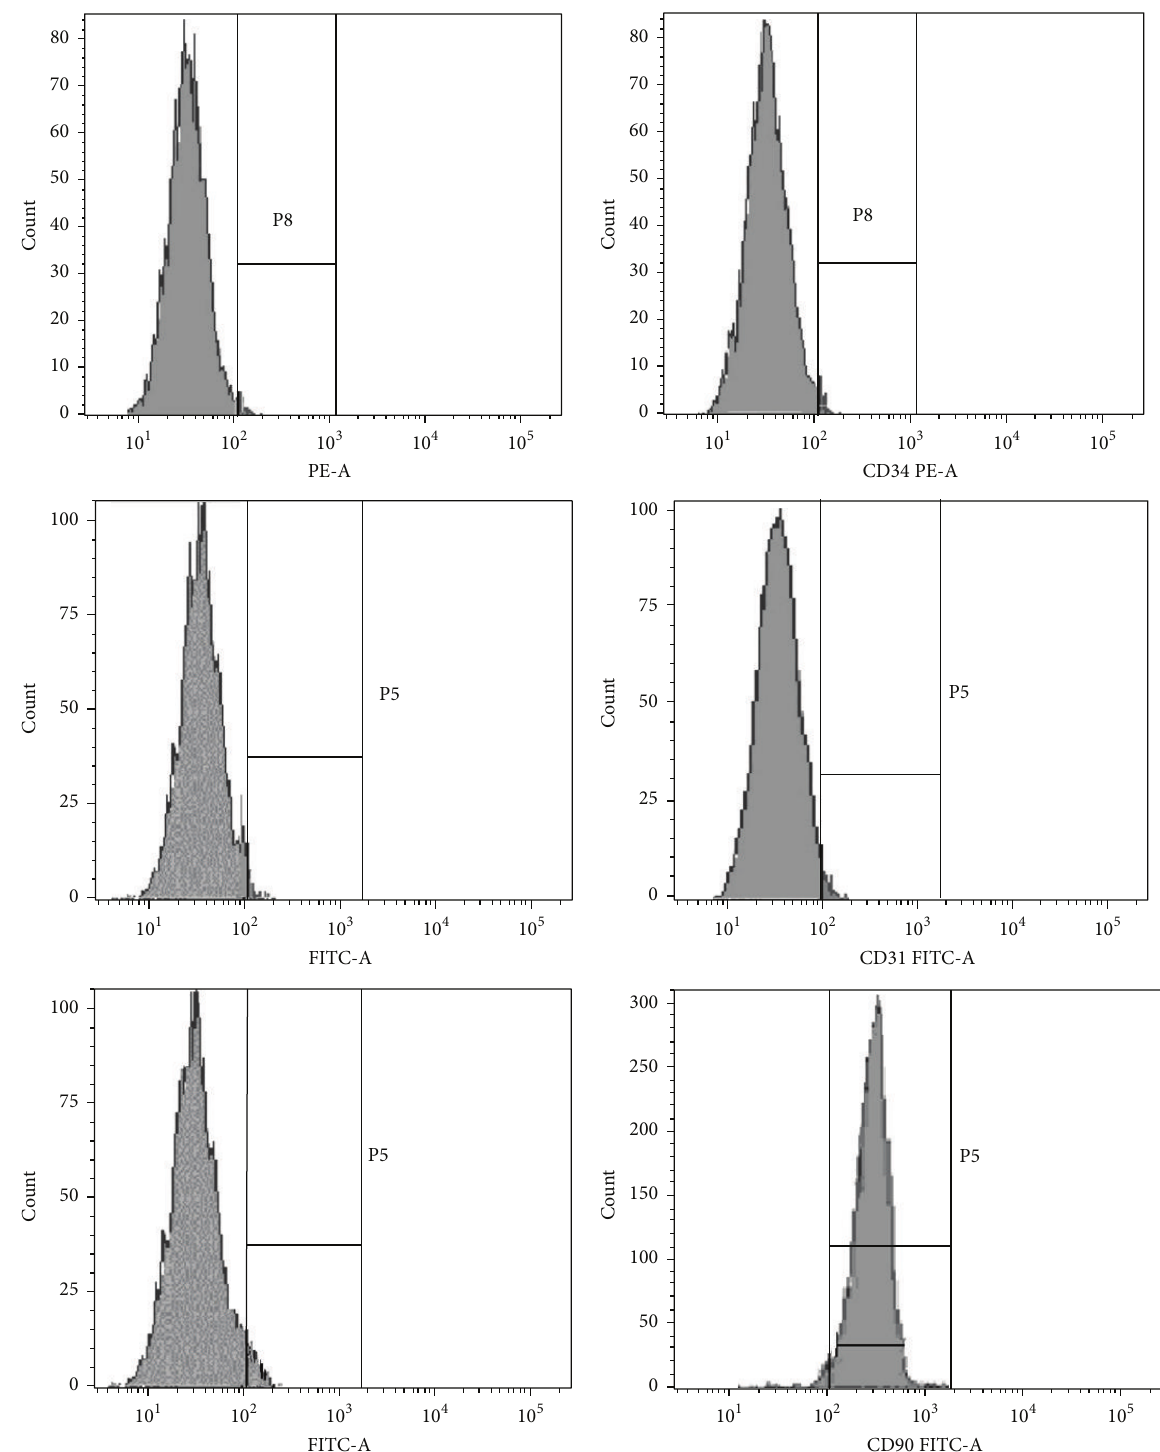
Figure 2: The cell surface markers of cultured ASCs. Flow cytometry indicated that ASCs represented a homogenous population of cells with low expression of CD31 (0.3%) and CD34 (0.2%) and high expression of CD90